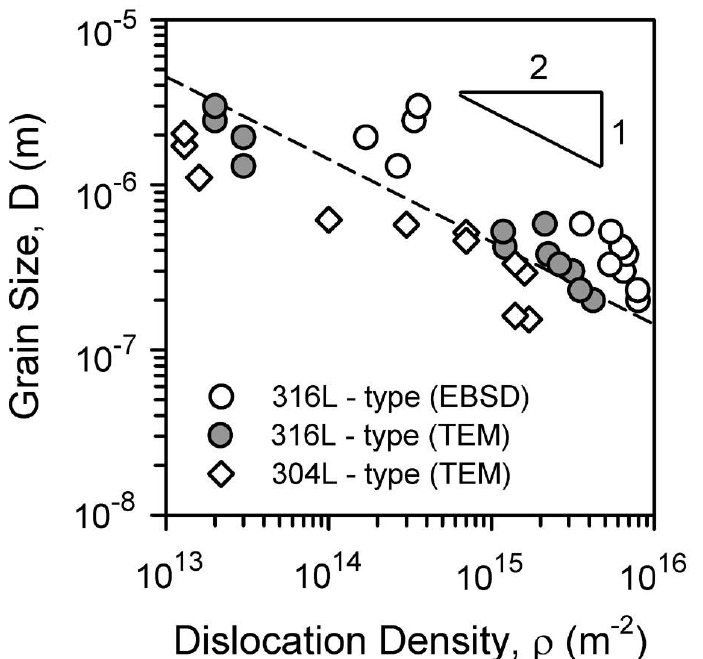
Figure 31. Relationships between the grain size and the dislocation density in UFG stainless steels processed by SPD and subsequent annealing [108].